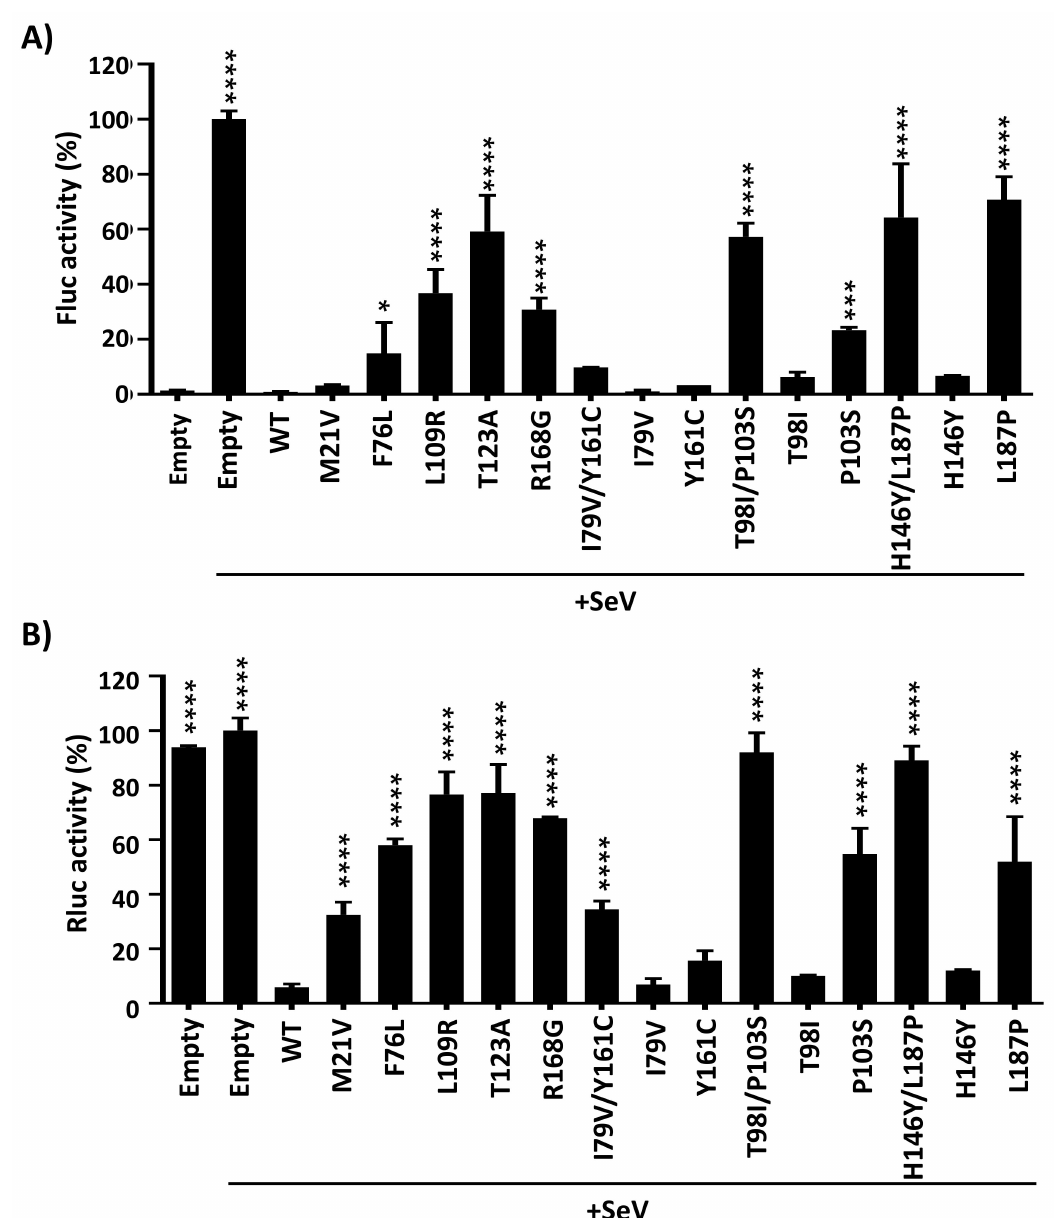
Figure 7. Effect of 1918 PA-X mutants on IFN-induced responses upon SeV infection. ( A , B ) HEK293T cells were transiently co-transfected with the indicated HA-tagged WT or mutant 1918 PA-X pCAGGS expression plasmids, together with plasmids expressing Fluc under the control of an ISRE promoter ( A ), or Rluc under an SV40 promoter ( B ). Empty pCAGGS plasmid was included as internal control. At 24 h p.t., cells were mock-infected or infected (MOI of 3) with SeV (+SeV) to induce ISRE promoter activation. At 21 h.p.i, cell lysates were prepared for reporter gene expression. Fluc ( A ) and Rluc ( B ) expression levels were measured by luminescence. Activity of Fluc and Rluc were normalized to the empty plasmid control (+SeV) transfected cells (100%). Results are the means and SDs of triplicates. Data are representative of three independent experiments. * p < 0.05; *** p < 0.0005; **** p < 0.0001; (1918 PA-X WT versus 1918 PA-X) using one-way ANOVA and Dunnett’s test for multiple comparison